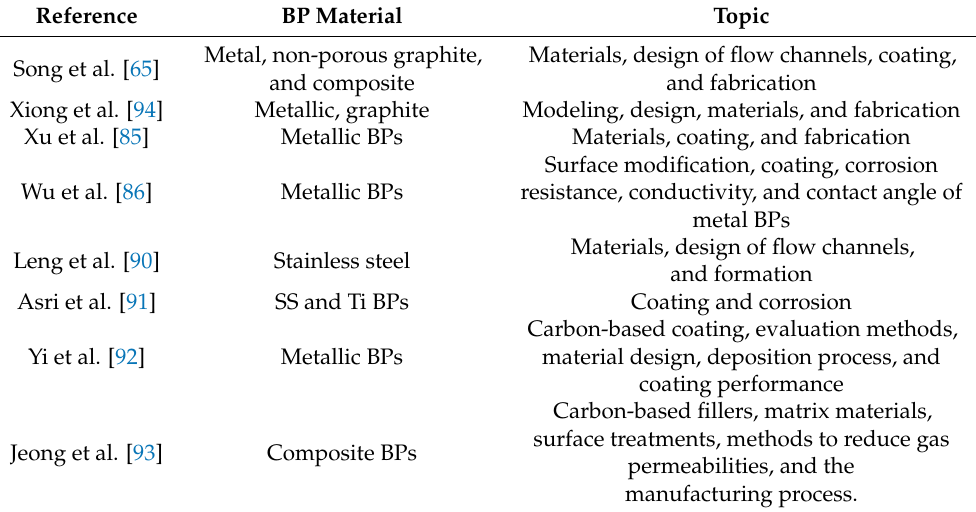
Table 5. The latest review articles about BPs and their design, coating, materials, and fabrication